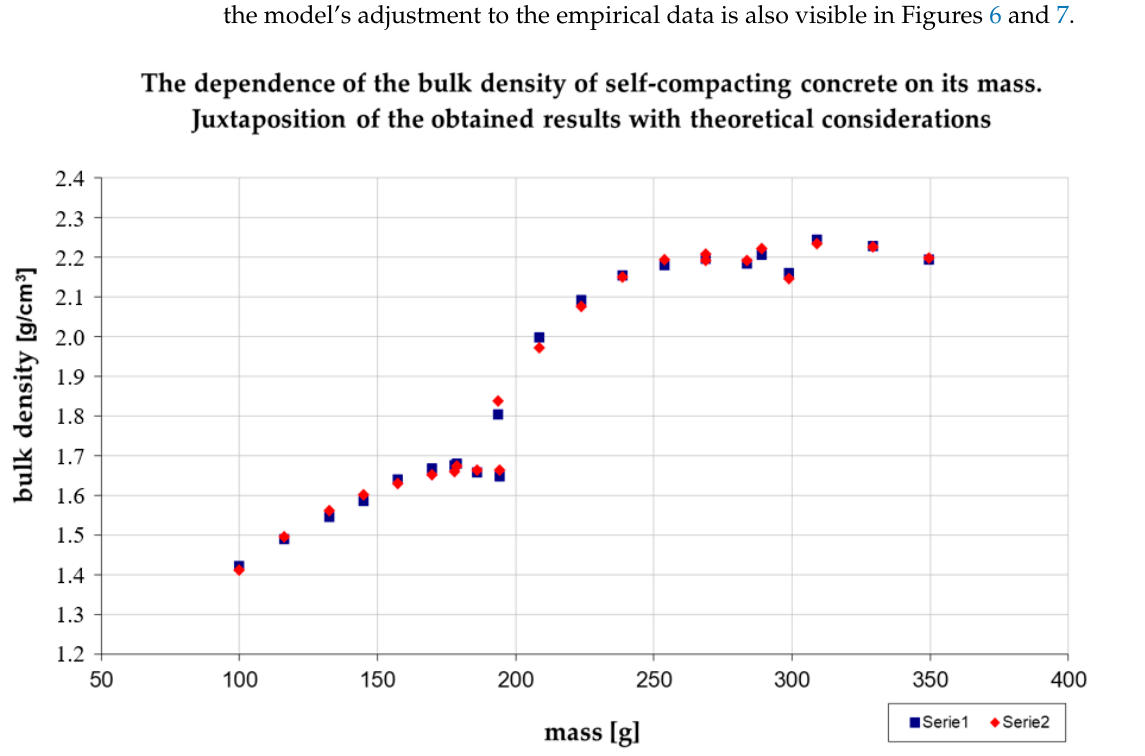
Figure 6. The dependence of the density of self-compacting concrete on its mass. Source: Own elaboration. Series 1—Theoretical values, Series 2—Empirical values determined in the analyses.